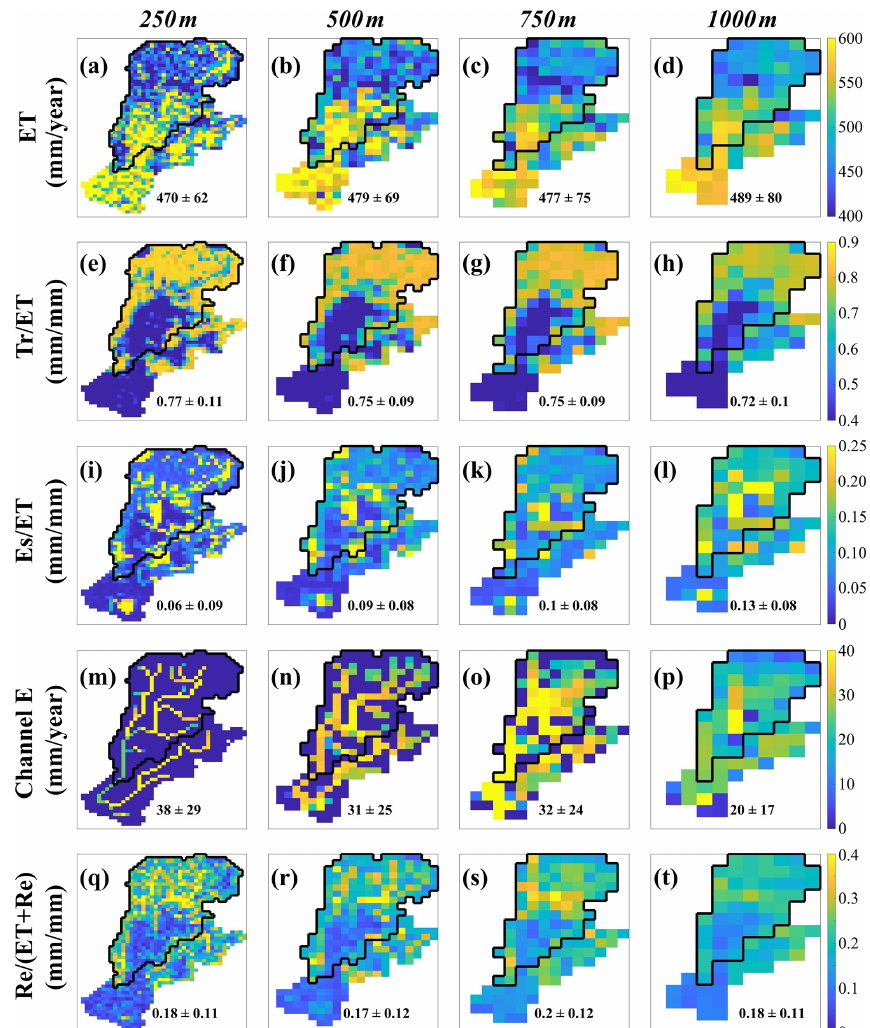
Figure 4. The (a–d) average annual evapotranspiration (ET), (e–h) ratio of transpiration (Tr) to ET, (i–l) ratio of soil evaporation (Es) to ET, (m–p) channel evaporation (channel E), and (q–t) the recharge proportion of vertical flux (recharge and ET) for the 250, 500, 750, and 1000m resolutions. Black boundaries show the calibration extent of the Demnitz Mill subcatchment. Values shown are the catchment-wide, long-term (2009–2019) average values and average standard deviation (average of each pixel) within the Demnitz Mill